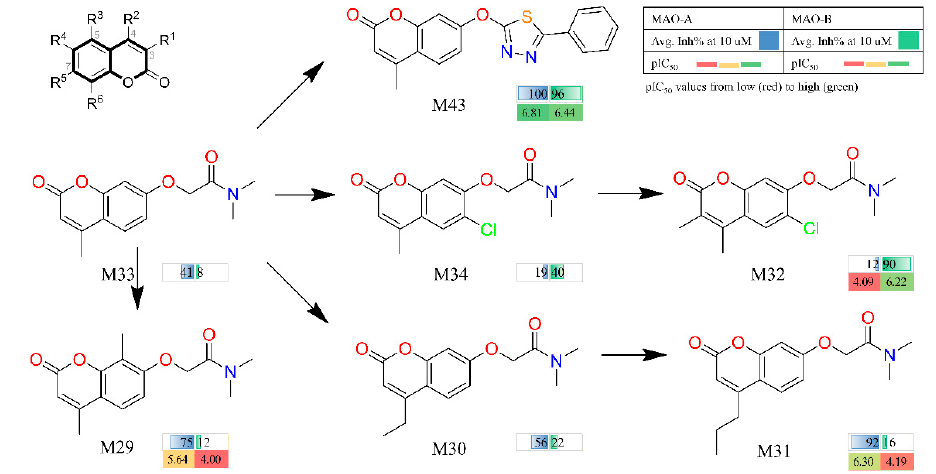
Figure 3. Identified coumarin analogues through BRS-3D with h MAO inhibitory activities.